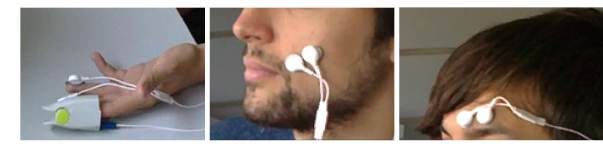
Figure 4. Placement of sensors for detecting